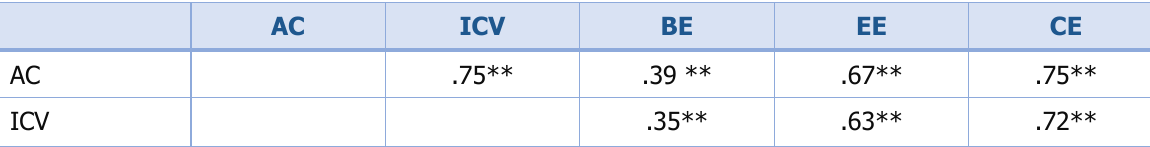
Table 4: Correlations of Participant’s Behavioral (BE), Emotional (EE), and Cognitive Engagement (CE) and Their Affective Commitment (AC) and Intention to Continue Volunteering (ICV)